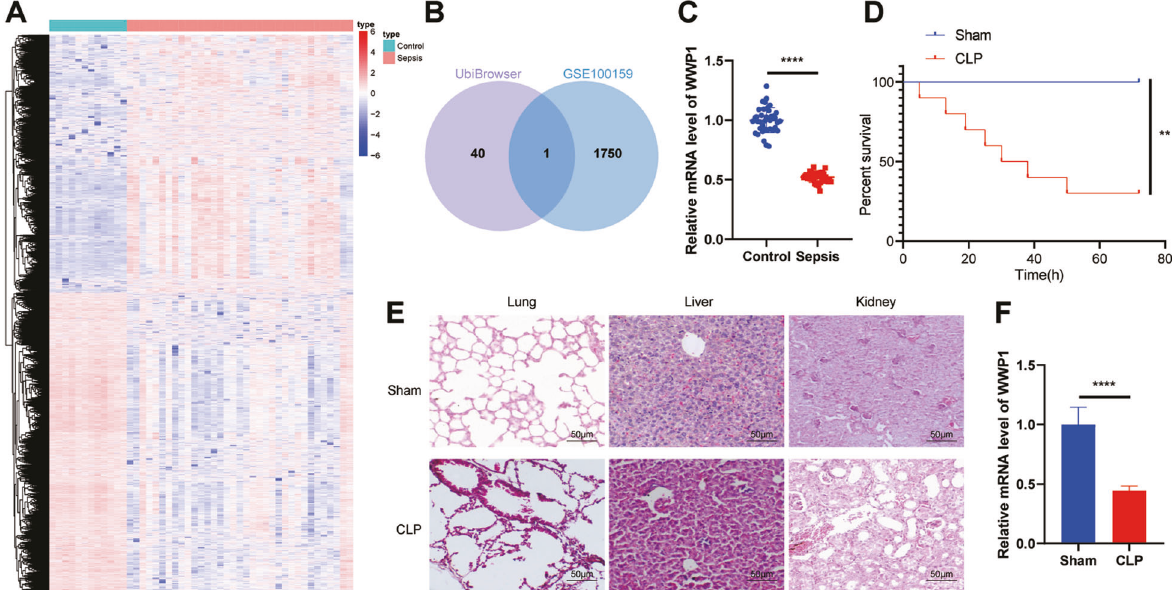
Fig. 1 WWP1 is downregulated in sepsis. A The thermal map of differentially expressed genes in GSE100159 (12 normal control samples and 35 sepsis samples). B The intersection of UbiBrowser database and downregulated genes in GSE100159 dataset. C The expression of WWP1 in PBMCs collected from sepsis samples ( n = 40) and healthy controls ( n = 40) detected by RT-qPCR. D The survival rates of CLP-induced mice. E The pathological changes of lung, liver and kidney of CLP-induced mice observed by HE staining. F The expression of WWP1 in PBMCs of CLP-induced mice detected by RT-qPCR. There were ten mice in each group. ** p < 0.01, **** p <